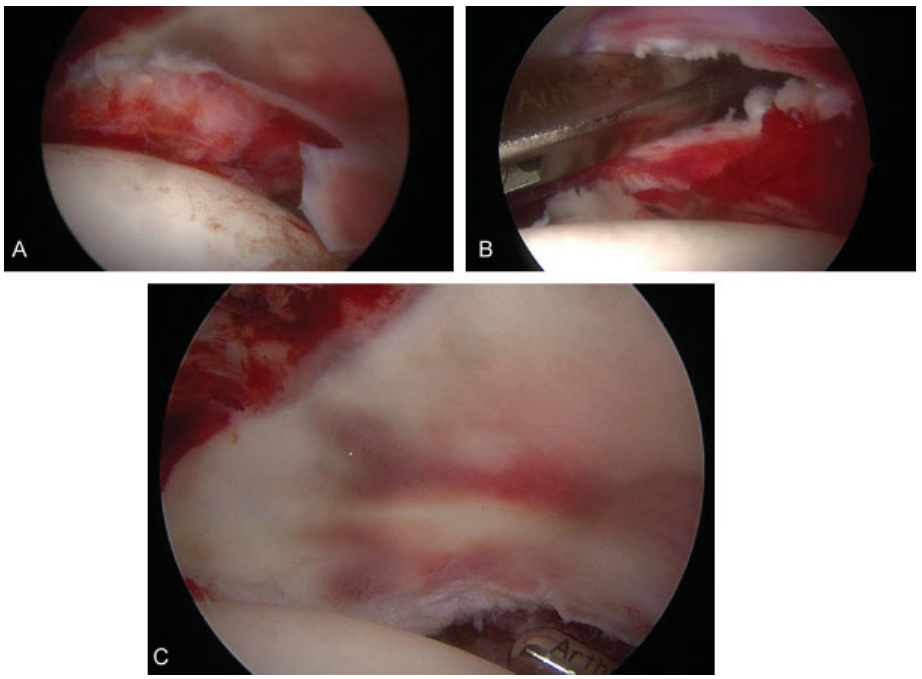
Fig. 4 ( A, B, and C ) Intraoperative images showing the enfolded labrum, which was reduced with careful manipulation with a hook. The labral complex was stable after reduction.